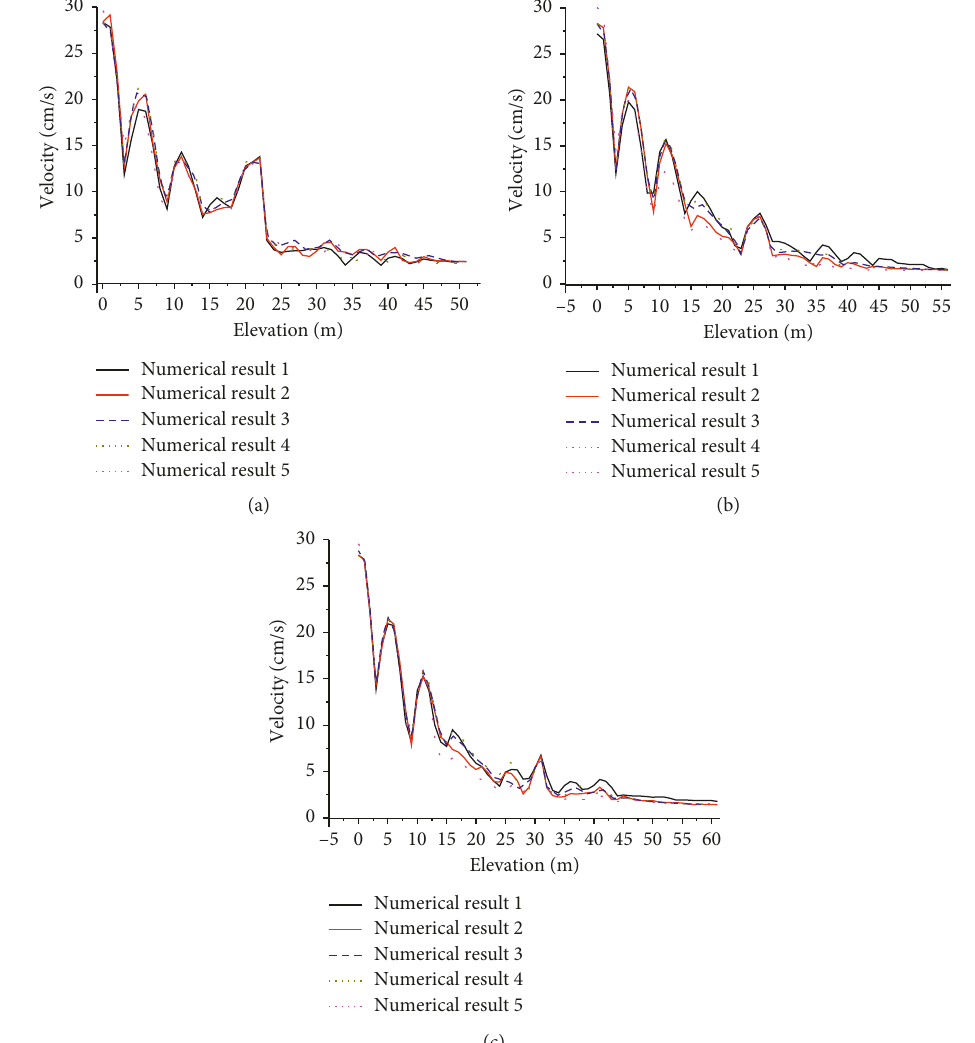
Figure 8: Vibration velocity curve of numerical simulation in the elevation direction for layered excavation of the powerhouse. The excavation vibration velocity curve with a horizontal distance of 0m for (a) the first layer, (b) the second layer, and (c) the third